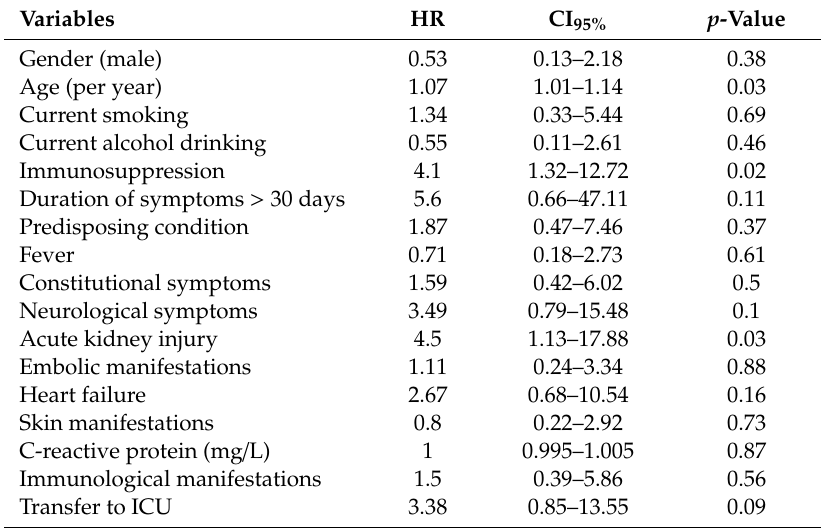
Table 5. Factors associated with death by univariate Cox proportional hazards regression